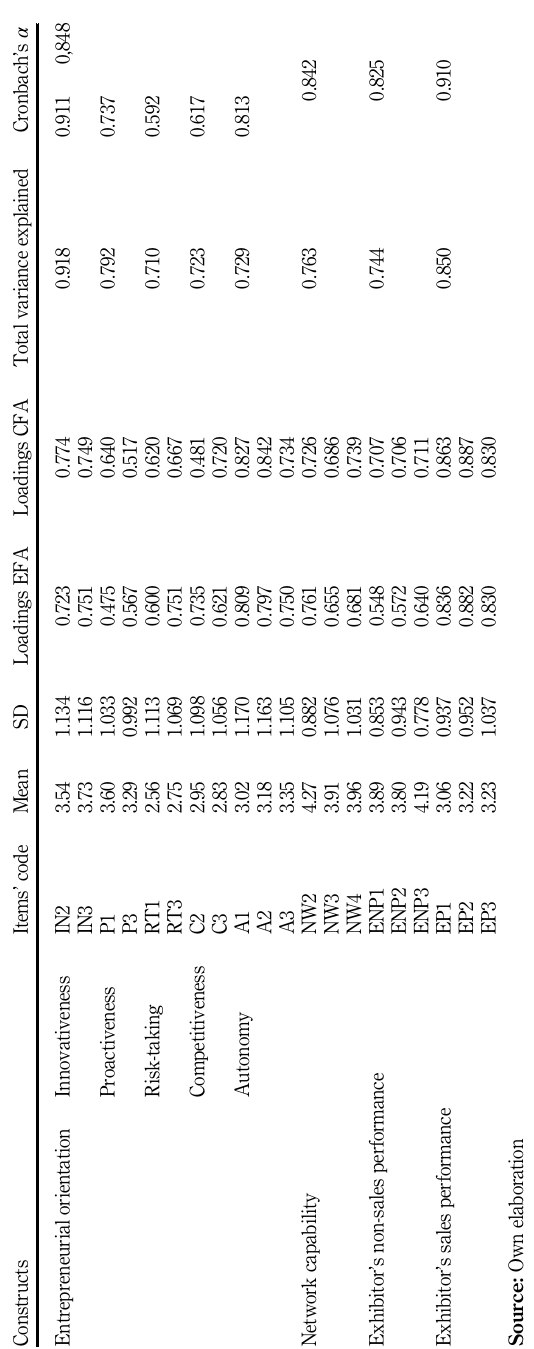
Table 3. Mean,SD,varianceand Cronbach ’ s